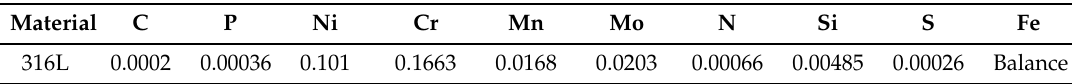
Table 2. Compositions in atomic percent of the material being